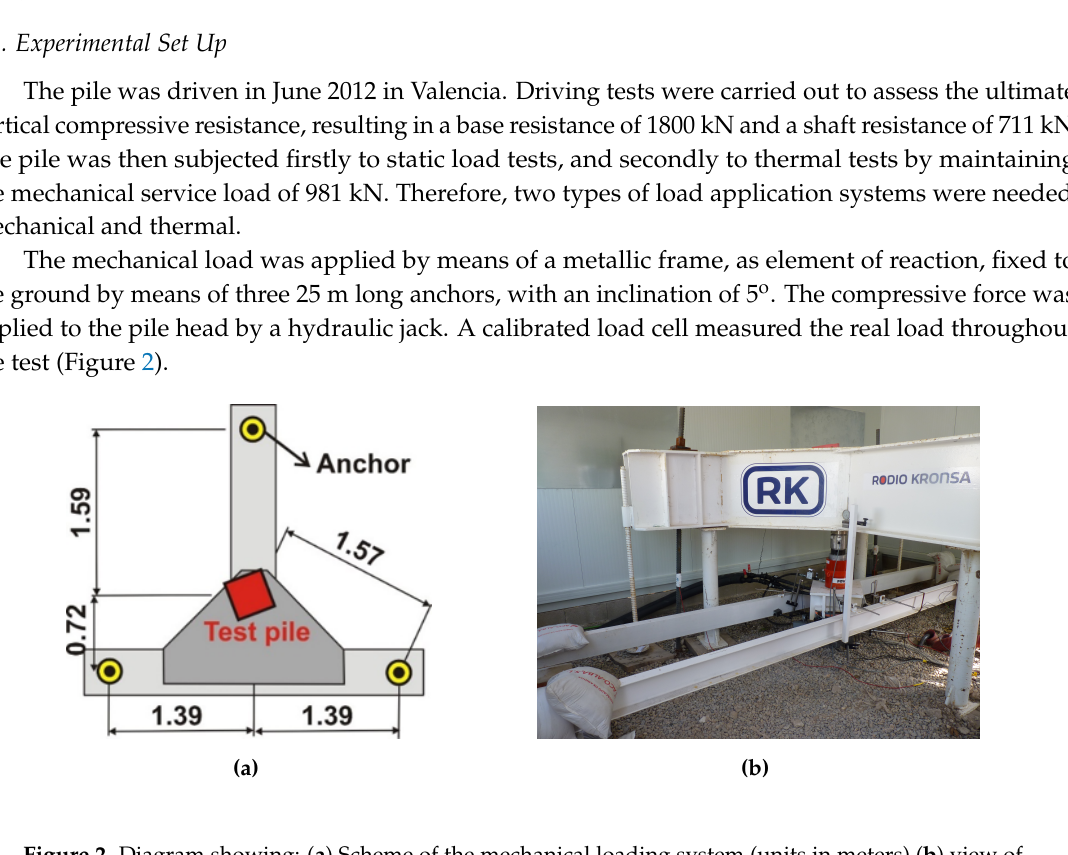
Figure 2. Diagram showing: ( a ) Scheme of the mechanical loading system (units in meters) ( b ) view of the metallic